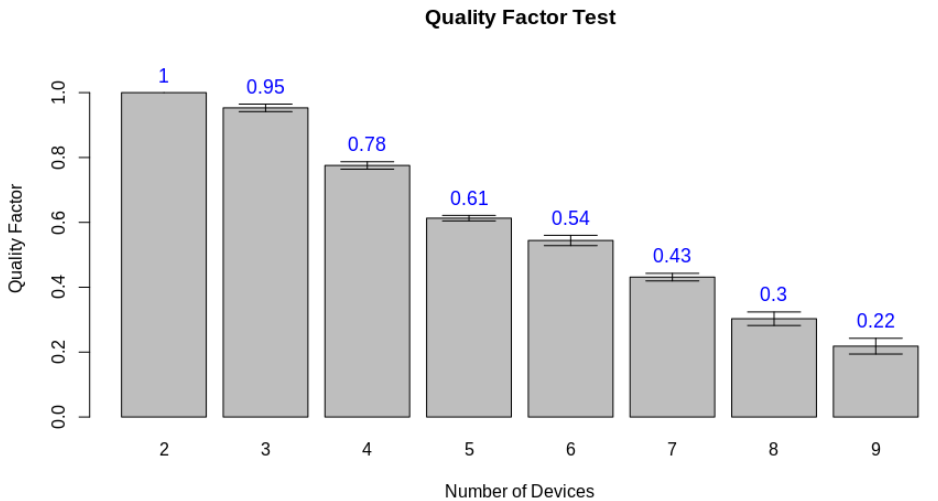
Figure 25. Quality factor test results.